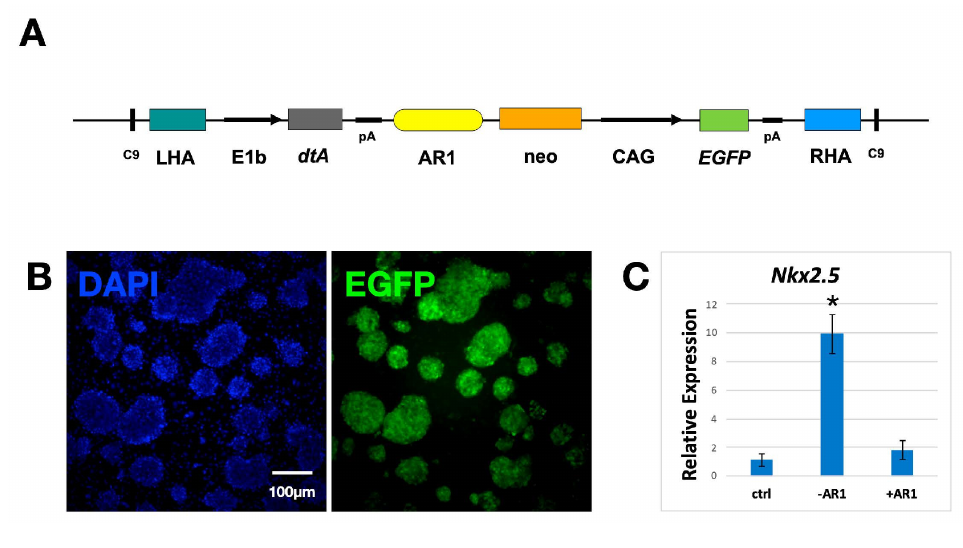
Figure 4. Generation of the “host” ES cell line. ( A ) Schematic of the “host” plasmid. It contains the diphtheria toxin gene dtA, under the control of the minimal promoter E1b and AR1 enhancer, the neomycin resistance cassette (neo) and EGFP gene under the control of the CAG promoter. The 3 cassettes are flanked by LHA, RHA and two CRISPR/Cas9 target sites (C9). ( B ) Stably transfected “host” colonies showing green fluorescence. ( C ) Real ‐ time RT ‐ PCR analysis showing relative ex ‐ pression of Nkx2.5 in differentiated “host” cells, in the absence and presence of AR1 (n = 3, * p < 0.05). In the presence of the enhancer, cardiac cells upregulate dtA and die, resulting in a marked drop in Nkx2.5 expression compared to control cells (without AR1). Ctrls are untransfected, undif ‐ ferentiated mESC. Primers are listed in the Supplementary Material (Table S3).